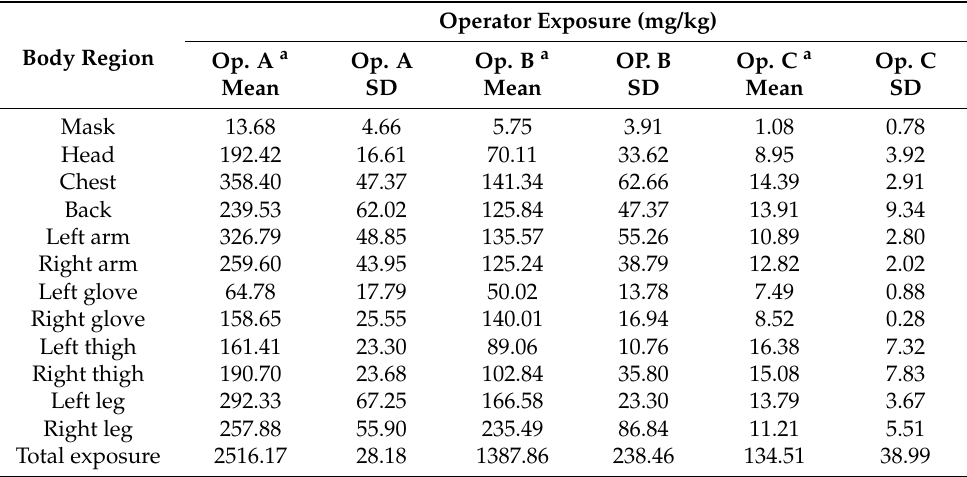
Table 3. Potential dermal exposure of operators ( n = 3) to Allure Red sprayed by knapsack electric and UAV